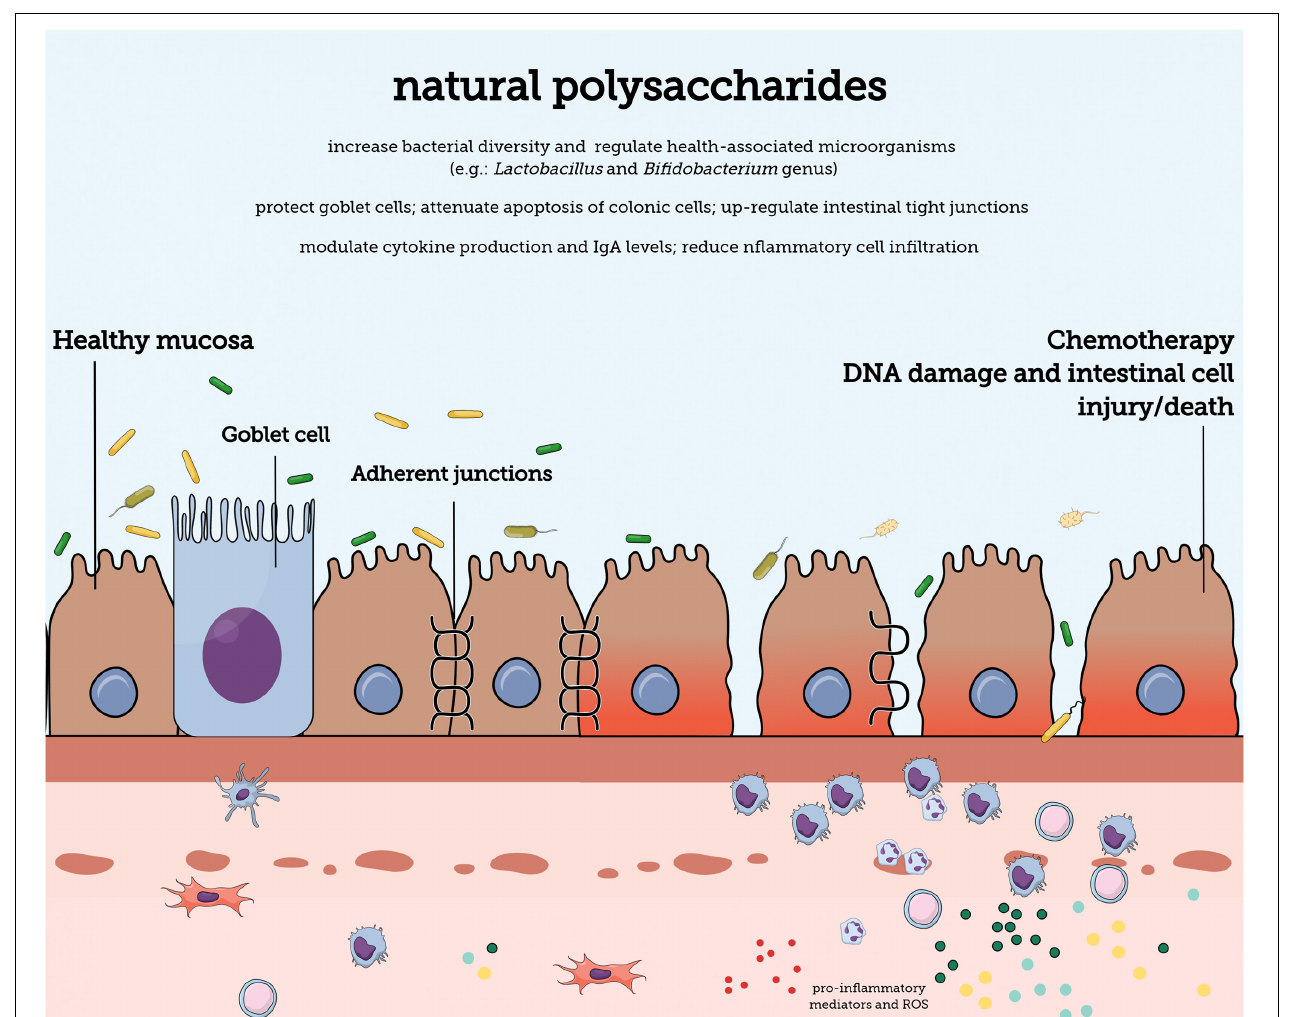
FIGURE 1 | The gastrointesti nal mucosal barrier. Natural polysaccharides can contain different structural characteristics and can protect the mucosa against damage caused by chemotherapy antineoplastic treatment. The mucosal barrier contains diverse barriers (e.g., mucus layer and adherent junction proteins) that promote protection against internal and external harmful substances. A single epithelial cell layer forms the physical barrier against the entry of antigens. The lamina propria is densely populated by cells of the immune system that provide protection against damaging